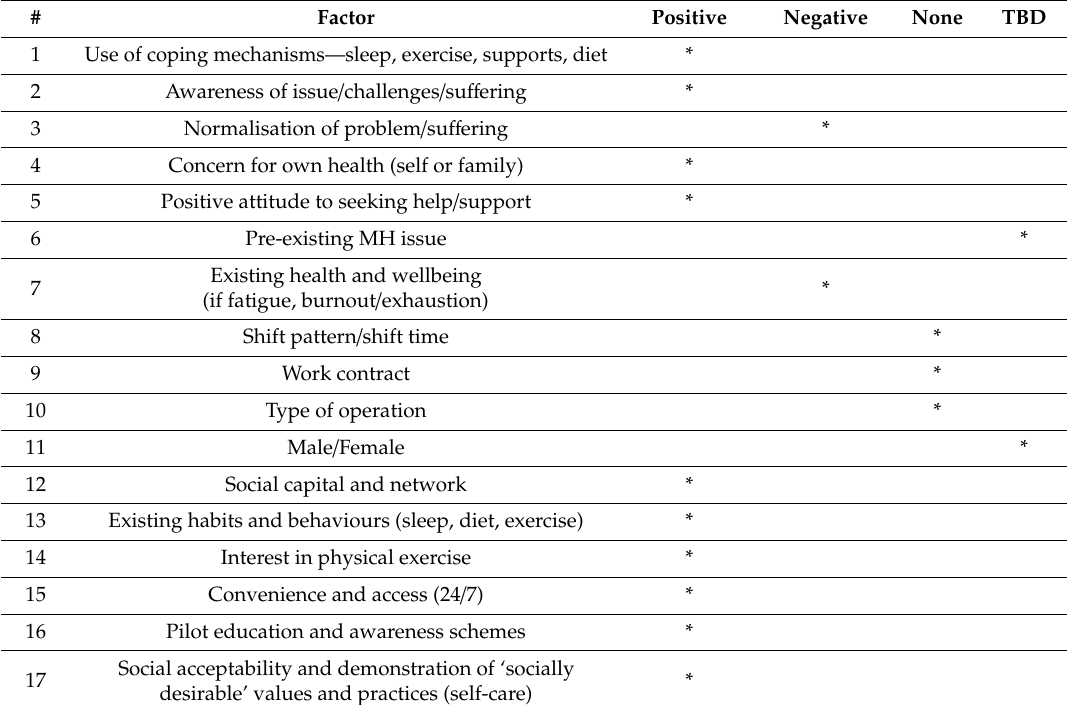
Table 3. Influencing factors .